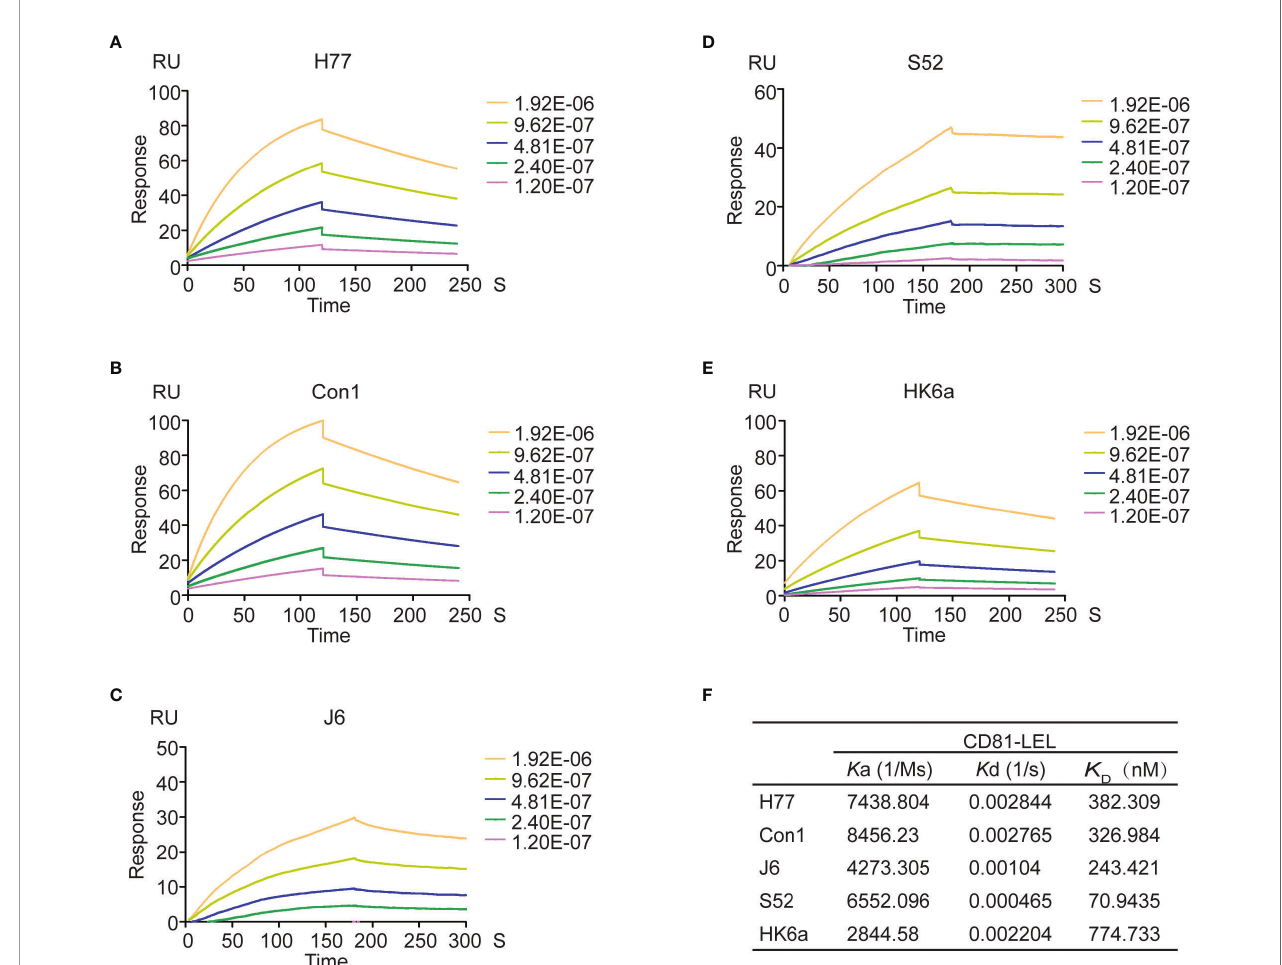
FIGURE 3 | Af fi nity and kinetic analysis of CD81 to Fc-E1E2 proteins. (A – E) Sensograms for Fc-E1E2 proteins from H77, Con1, J6, S52 and HK6a binding to immobilized CD81-LEL, respectively. Fc-E1E2 proteins concentrations were 0, 15.625, 31.25, 62.5, 125, 250 m g/ml. (F) K a, K d, K D values of Fc-E1E2 proteins from H77, Con1, J6, S52 and HK6a binding to CD81-